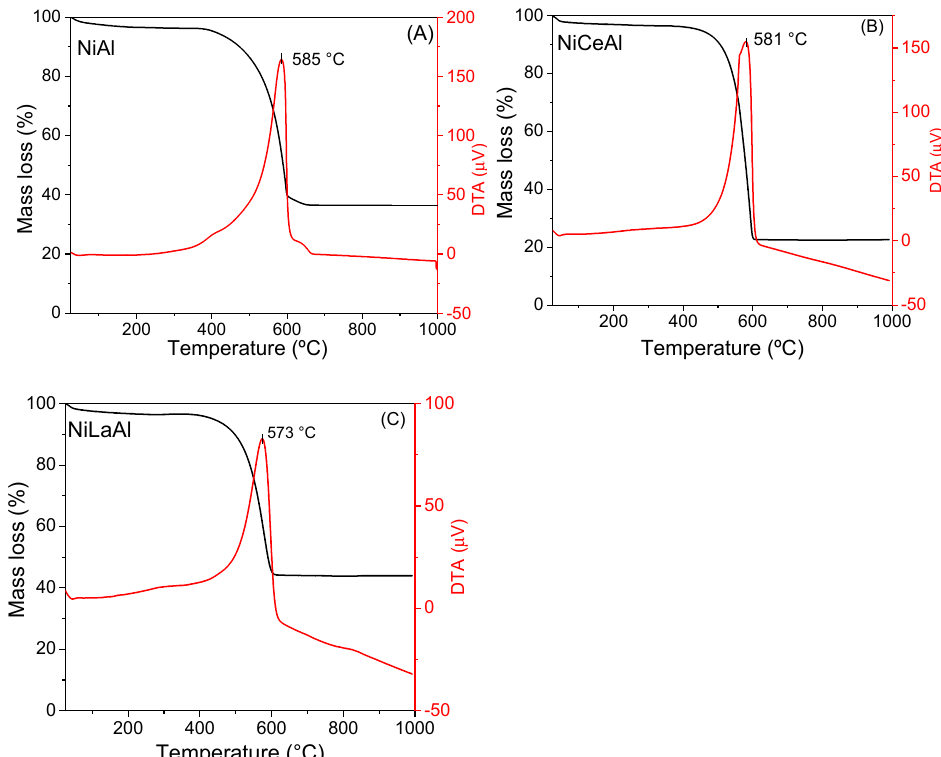
Figure 8. TGA and DTA profiles of NiAl ( A ), NiCeAl ( B ), and ( C ) NiLaAl after 30 h of butanol steam reforming reaction at 500 °C.